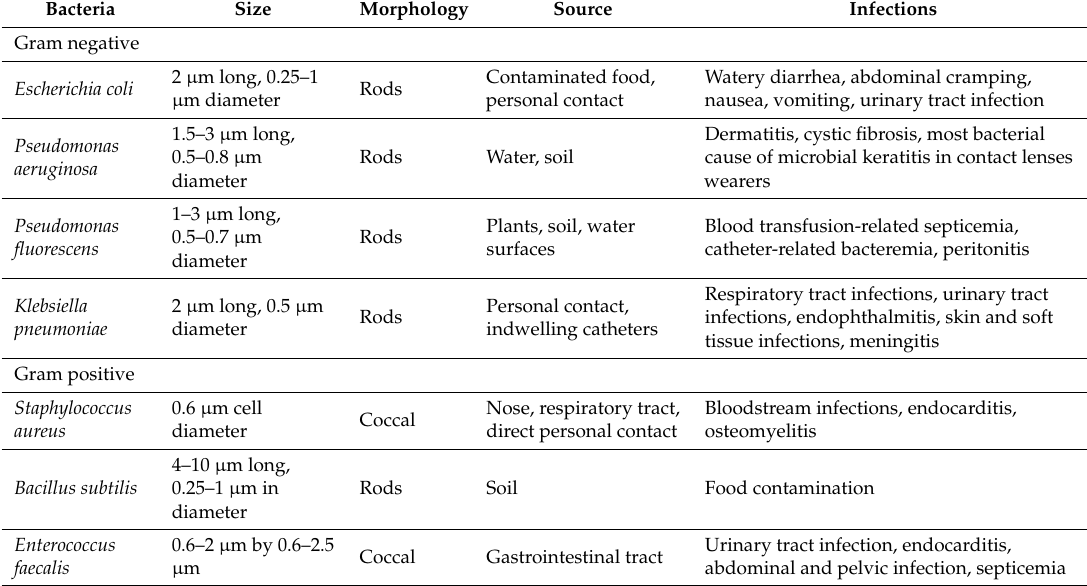
Table 1. Pathogenic bacteria